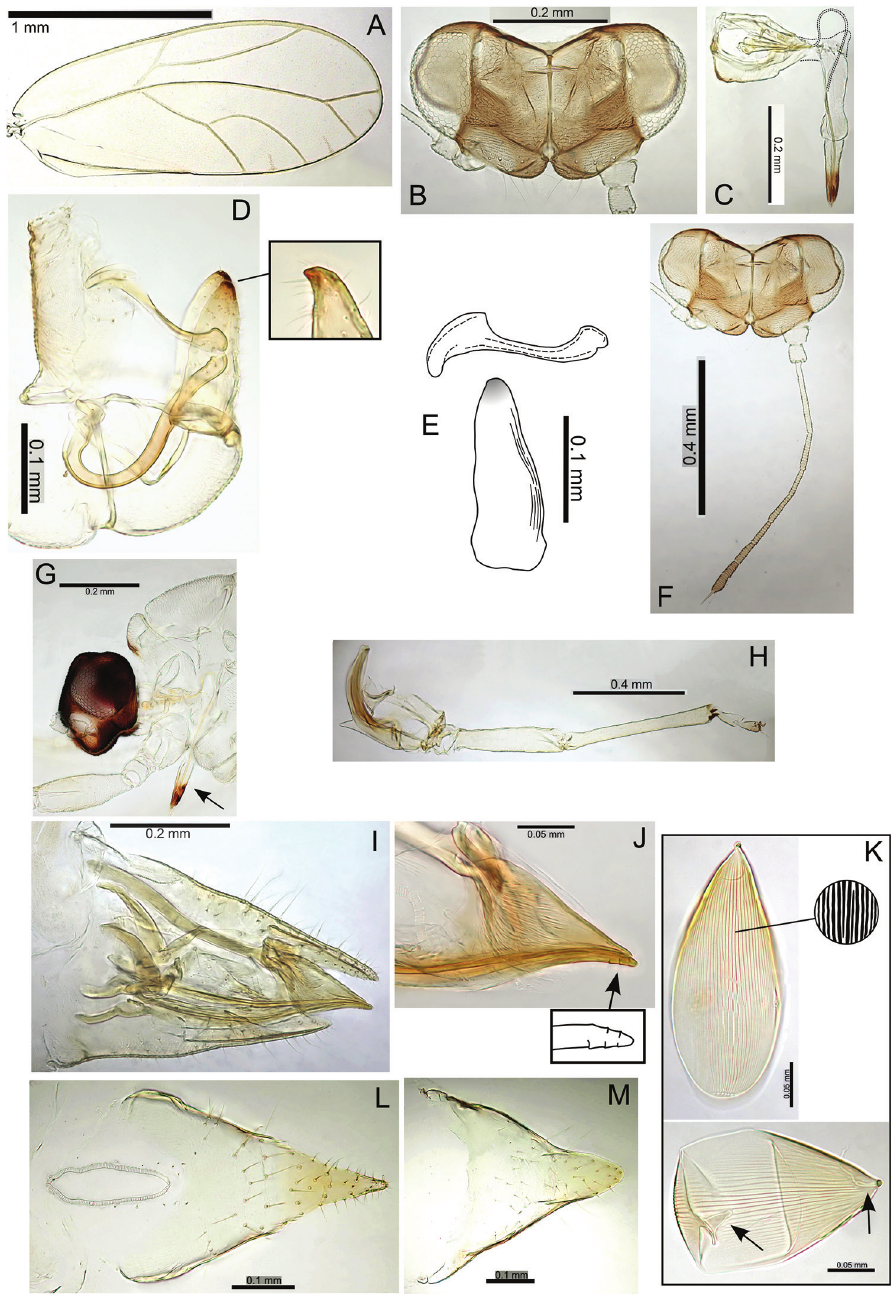
Figure 11. Pariaconus proboscideus sp. n. A fore wing B head C proboscis D male terminalia with dorsal view of paramere apex (inset) E aedeagus and paramere F head and antenna G head (with long distal pro- boscis segment indicated) H hind leg I female terminalia J ovipositor (serrations indicated) K eggs (pedicel, tail, and striations indicated) L female proctiger (dorsal view) M female subgenital plate (ventral